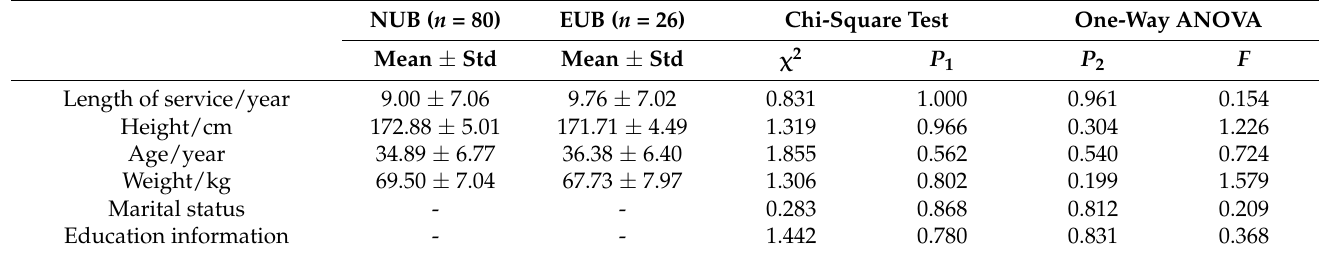
Table 1. The demographic information of 106 subjects, Chi-square test, and one-way ANOVA test.